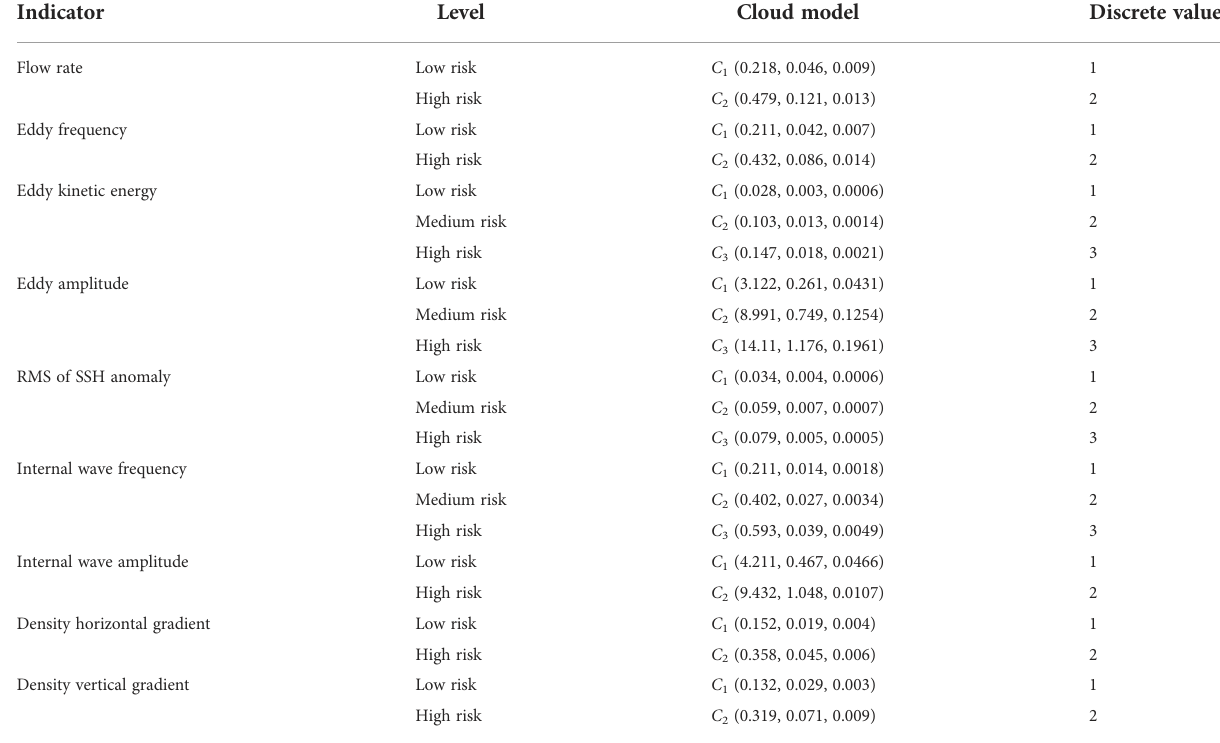
TABLE 3 Cloud model expression of indicator